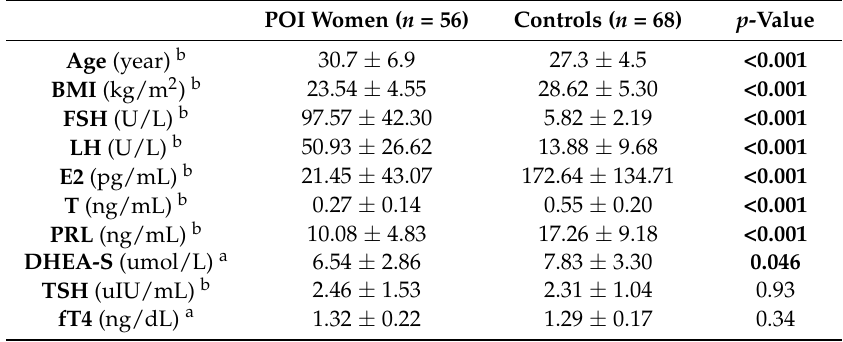
Table 1. Demographic, clinical, and hormonal parameters of POI and control groups.